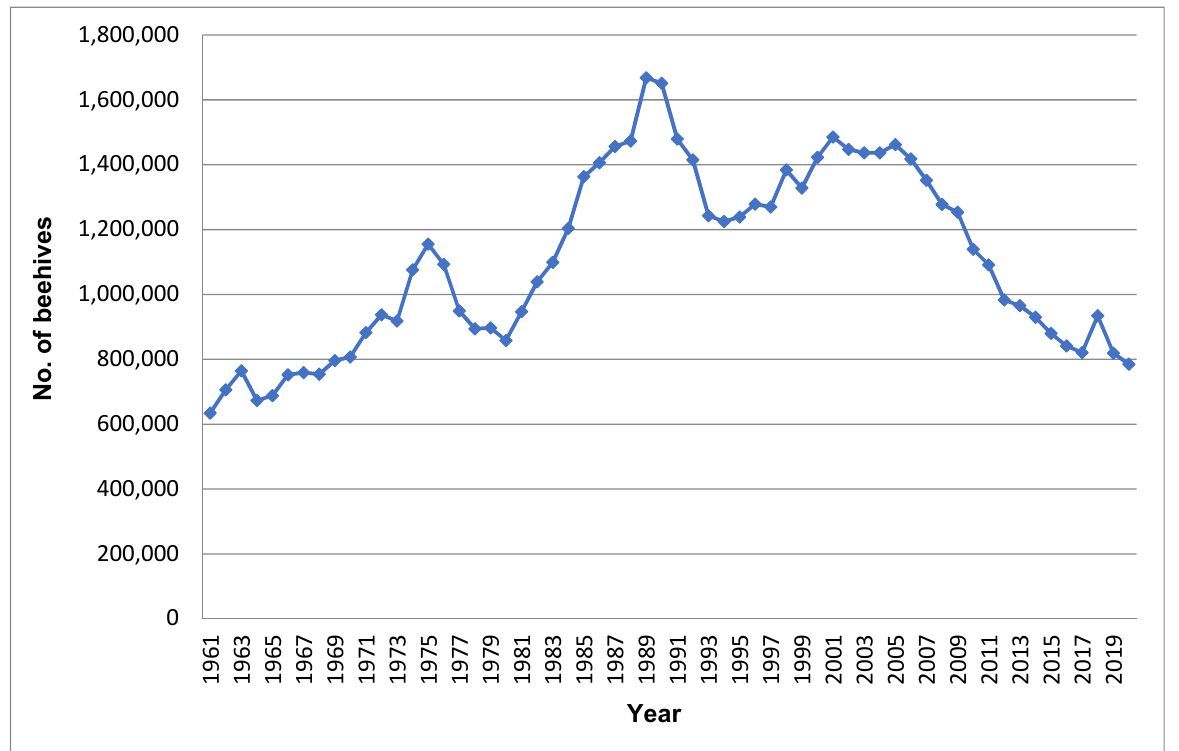
Figure 3. The Egyptian mud traditional hives ( A1 – A3 ) and modern ones ( B ). (Photo A1 – A3 : Dahy M. Mostafa and used with permission).